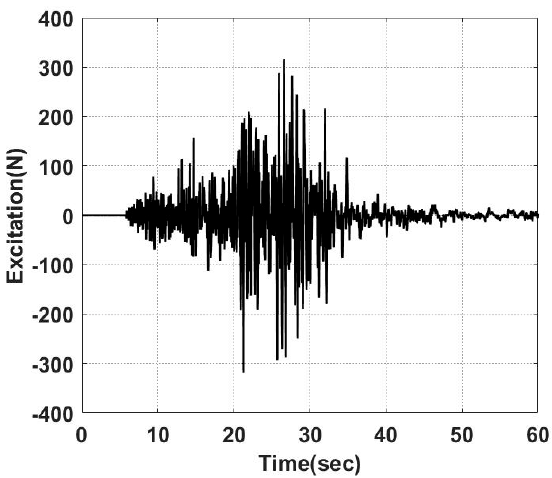
Figure 14. A recorded sample of the Chi-Chi earthquake.